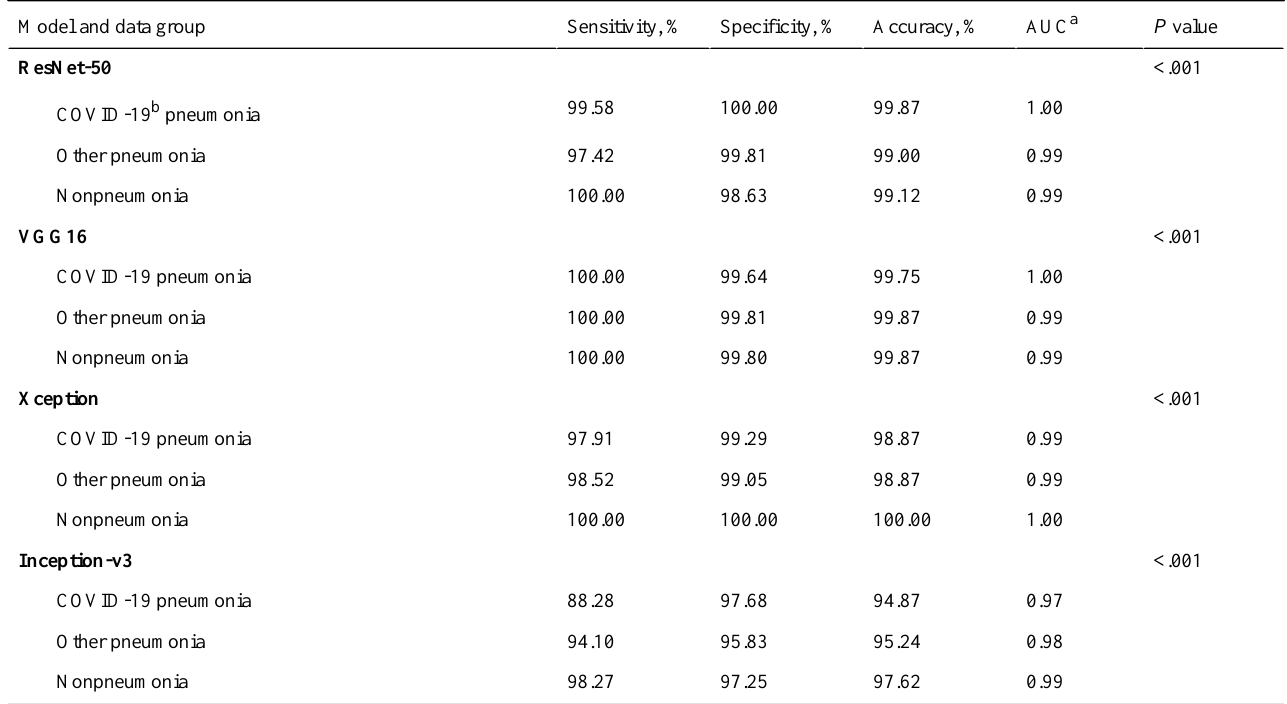
Table 4. Performance of the FCONet frameworks based on the four pretrained models on the testing data set.